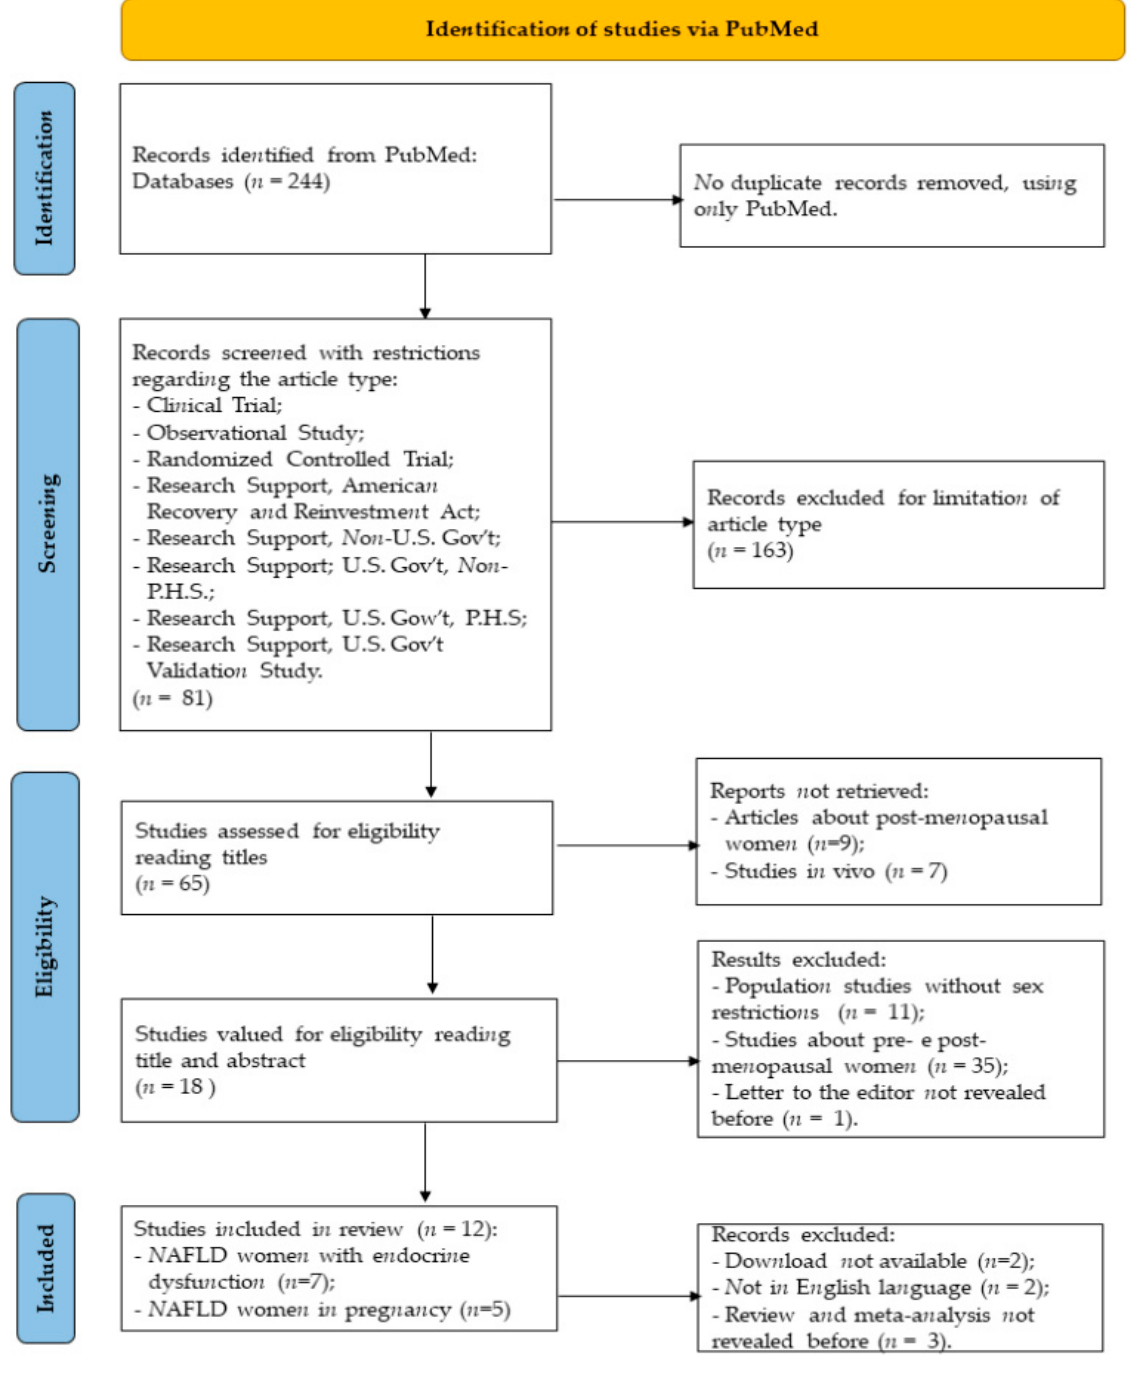
Figure 1. Identification of studies on PubMed. The methodology used to identify the work analyzed is summarized in 4 steps: identification, screening, eligibility and inclusion.